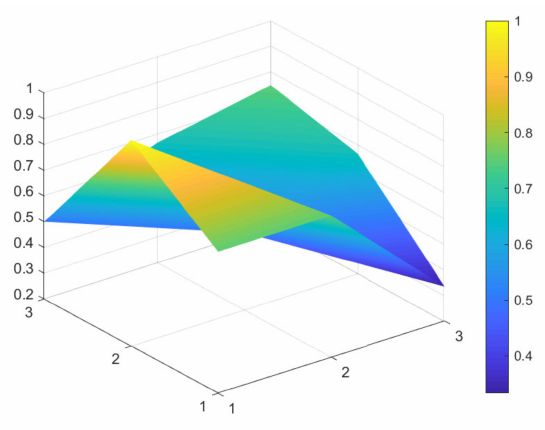
Figure 4. PMC-Surface chart of P9 (Good).